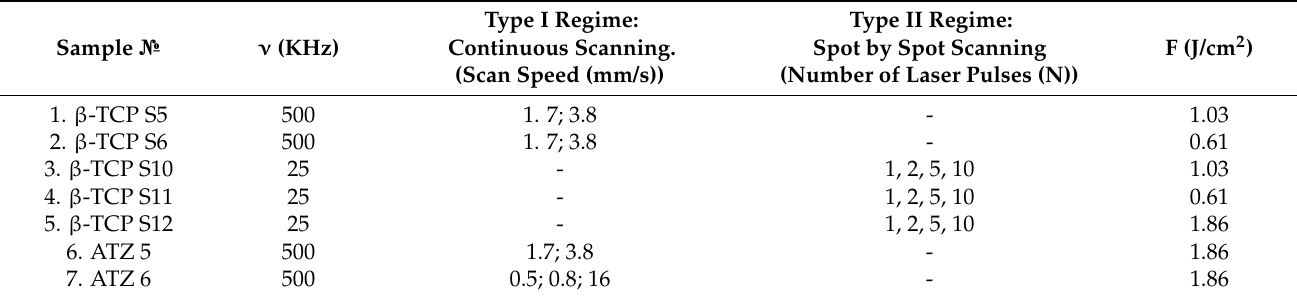
Table 2. Parameters employed for texturing in two different regimes of femtosecond laser patterning.